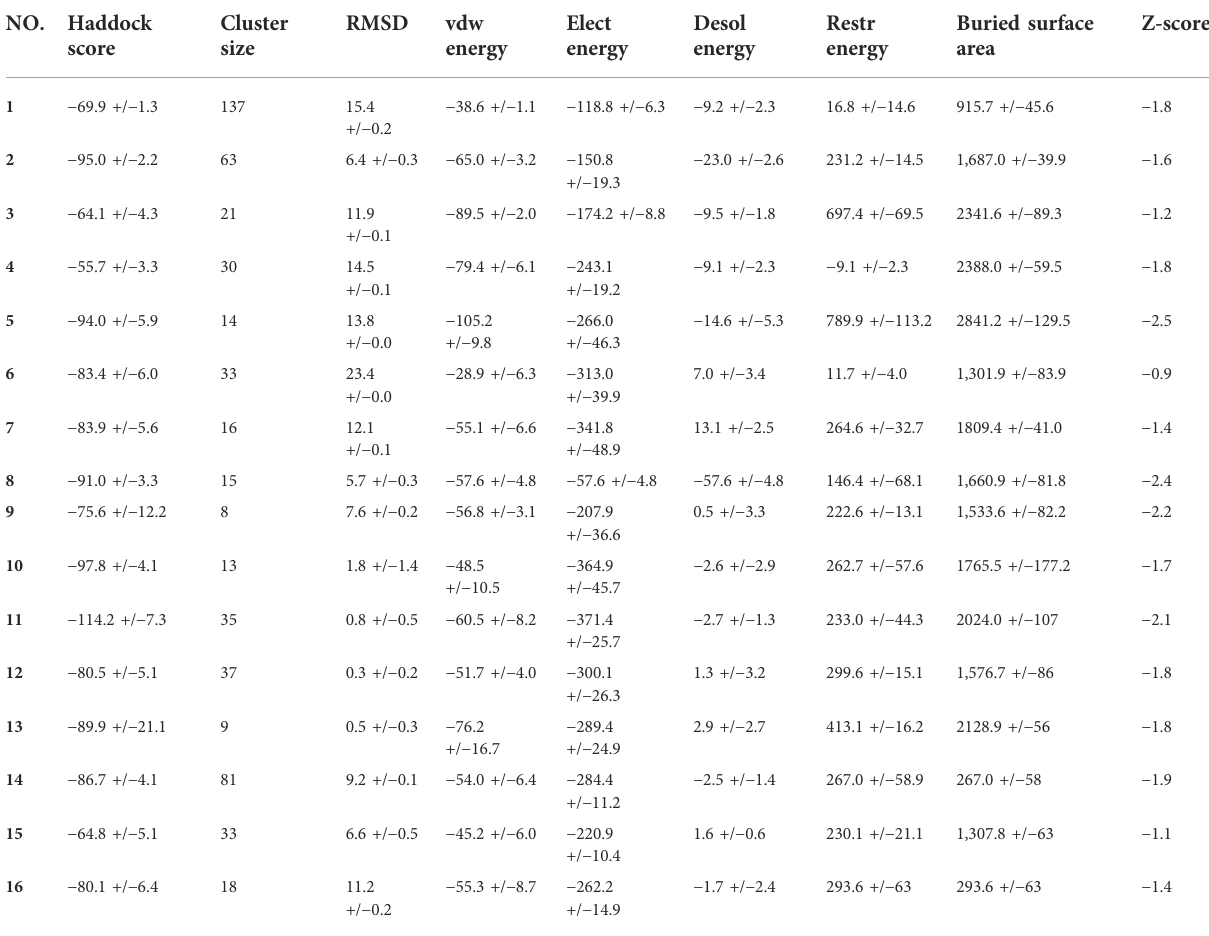
TABLE 1 Molecular docking data, represented with the HADDOCK